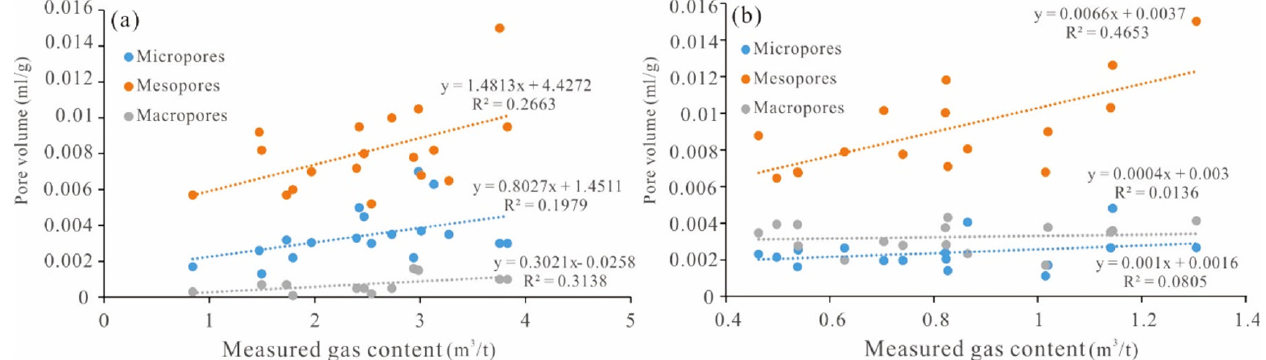
Figure 11. Effects of pore size on gas content in the Silurian Longmaxi marine shale ( a ) and Dongyuemiao lacustrine shale ( b ).